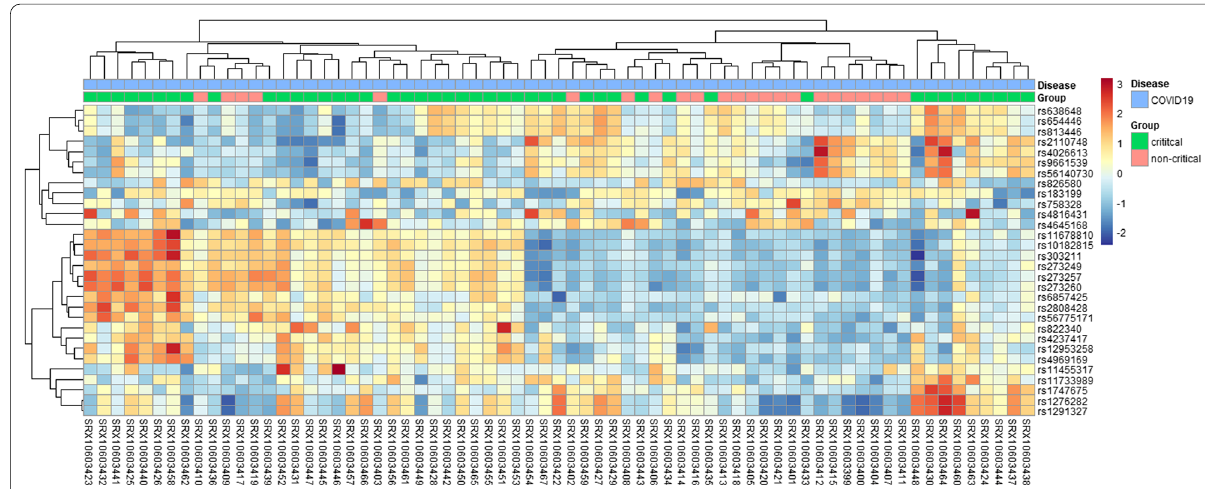
Fig. 2 Heatmap showing the relative abundance of the top 30 most abundant single nucleotide polymorphisms in critical and non-critical SARS-CoV-2-infected individuals. The samples were both collected from individuals infected with SAR-CoV-2. In the legend, the “green” color denotes the critically ill individuals, and “red” denotes the non-critical individuals. The color scale ranges from red (more abundant) to blue (less